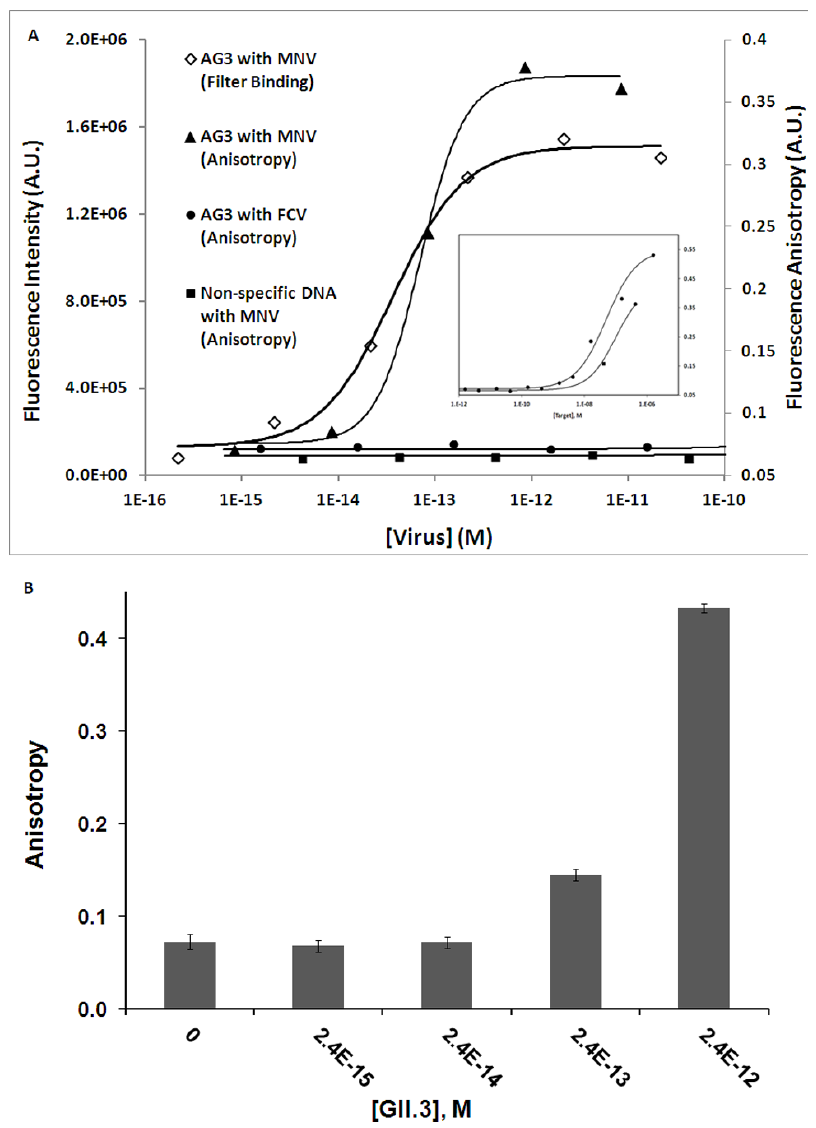
Figure 3. Binding assays. A) Binding affinity measurements for 5 9 -fluorescein-modified AG3 with MNV using a polycarbonate filter binding assay (diamonds) and a fluorescence anisotropy assay (triangles). The binding affinity of 5 9 -fluorescein tagged AG3 to FCV (circles) as well as a non-specific DNA control with MNV (squares) were also measured by anisotropy. Measurements are fitted using either the Hill or Logistic functions (solid lines). Inset: Much higher concentrations of virus are required in order to show any anisotropy change in the controls. B) Fluorescence anisotropy results from binding of 5 9 -fluorescein-modified AG3 with varying concentrations of GII.3 HuNoV capsid. surface, as evidenced by very large redox currents ( curve a ) shown in Fig. 4A. Formation of a self-assembled monolayer of the thiolated aptamer onto the gold surface substantially reduced the electrode current (curve b), indicating the formation of a more compact blocking layer. The concentration of the aptamer (500 nM) was optimized to maximize surface density. Final treatment with 2- mercaptoethanol further reduced the redox current because it can penetrate down to the electrode surface, thereby blocking direct access of the conducting ions ( curve c ). The thiol group of the back- filling agent can effectively displace the weaker adsorption contacts between the aptamer nucleotides and the gold surface, leaving the capture probe tethered primarily through the thiol end group.